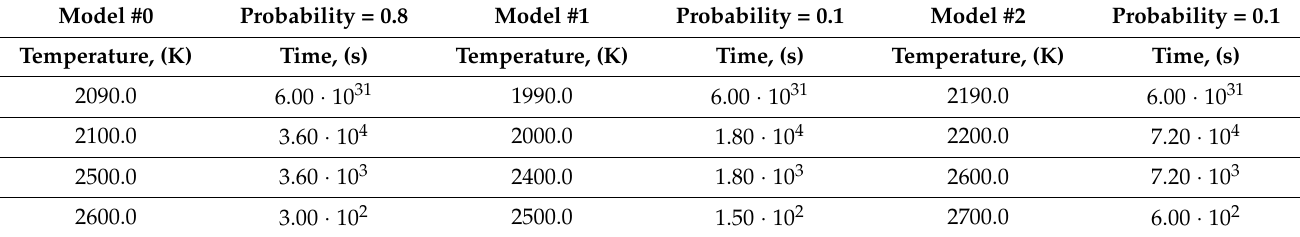
Table 4. Alternative versions of the time-at-temperature model. Model 0—best estimate. Model #0 Probability = 0.8 Model #1 Probability = 0.1 Model #2 Probability =